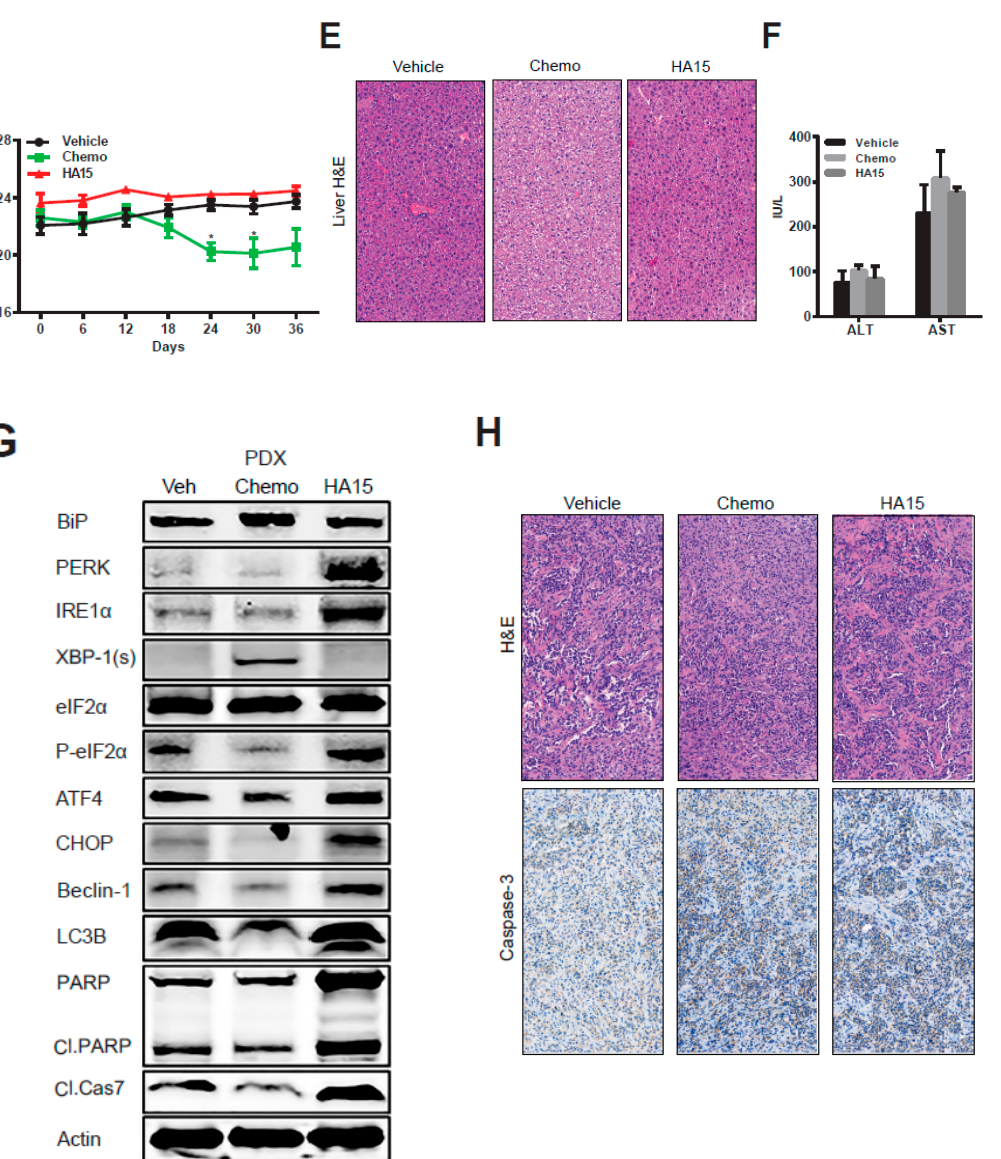
Figure 6. HA15 suppresses MPM tumor growth in vivo. ( A ) Growth curves of patient (BE261T)-derived xenograft (PDX) tumors treated with the vehicle, cisplatin / pemetrexed (3.75 / 83 mg / kg; chemo), or HA15 (0.7 mg / mouse) for the indicated time. Data are presented as mean ± SEM ( n = 4). * p < 0.05, ** p < 0.01, and **** p < 0.0001 by two-way ANOVA with Dunnett’s multiple comparisons test. ( B , C ) Tumor size ( B ) and weights ( C ) of PDX (BE261T) tumors after the treatment. Data are presented as mean ± SEM ( n = 4). * p < 0.05, ** p < 0.01, *** p < 0.001, and **** p < 0.0001 by one-way ANOVA with Dunnett’s multiple comparisons test. ( D ) Mice body weights during treatment with HA15, chemo, or vehicle. Data are presented as mean ± SEM ( n = 4). * p < 0.05 by two-way ANOVA with Dunnett’s multiple comparisons test. ( E ) Liver histology from treated mice. Original overall magnification, × 400. ( F ) Transaminase (AST / ALT) activities of treated mice. Data are presented as mean ± SEM ( n = 3). ( G ) Immunoblots of PDX tumors after the treatment. Protein quantification is shown underneath, whereby signal intensity was assessed by ImageJ and normalized to the loading control ( β -actin), with the value of the vehicle group set as 1. ( H , E ) Staining and IHC analysis for caspase-3 of PDX tumors after the treatment. Original overall magnification, ×